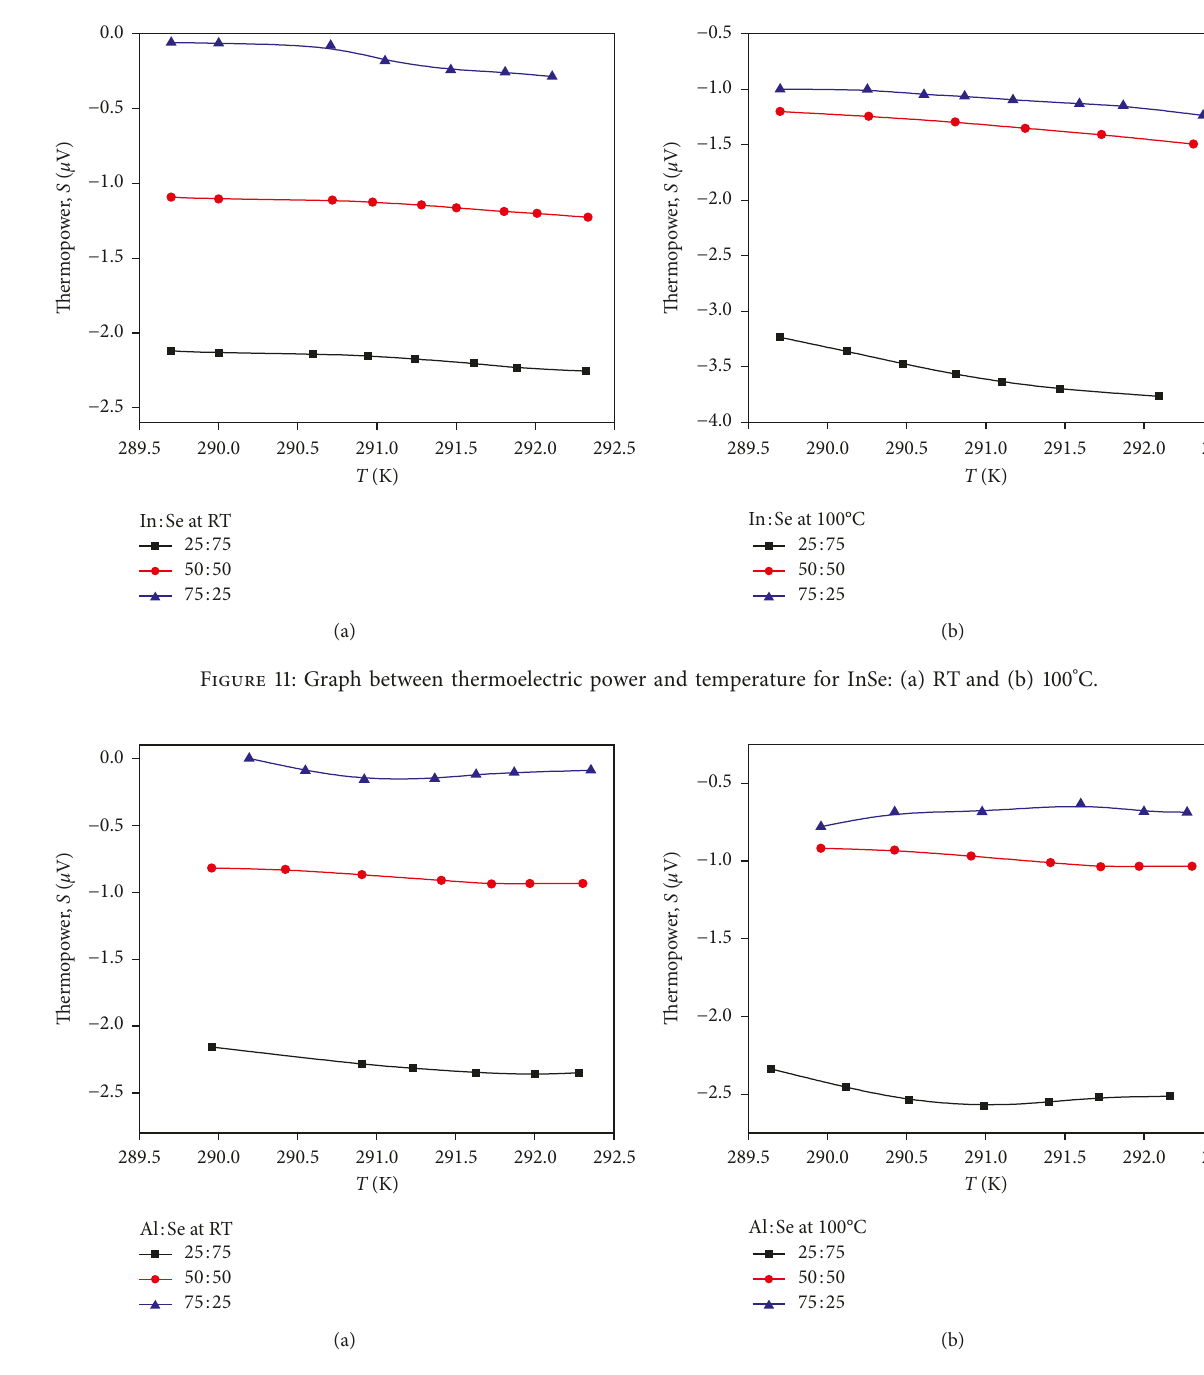
Figure 12: Graph between thermoelectric power and temperature for AlSe: (a) RT and (b) 100 °